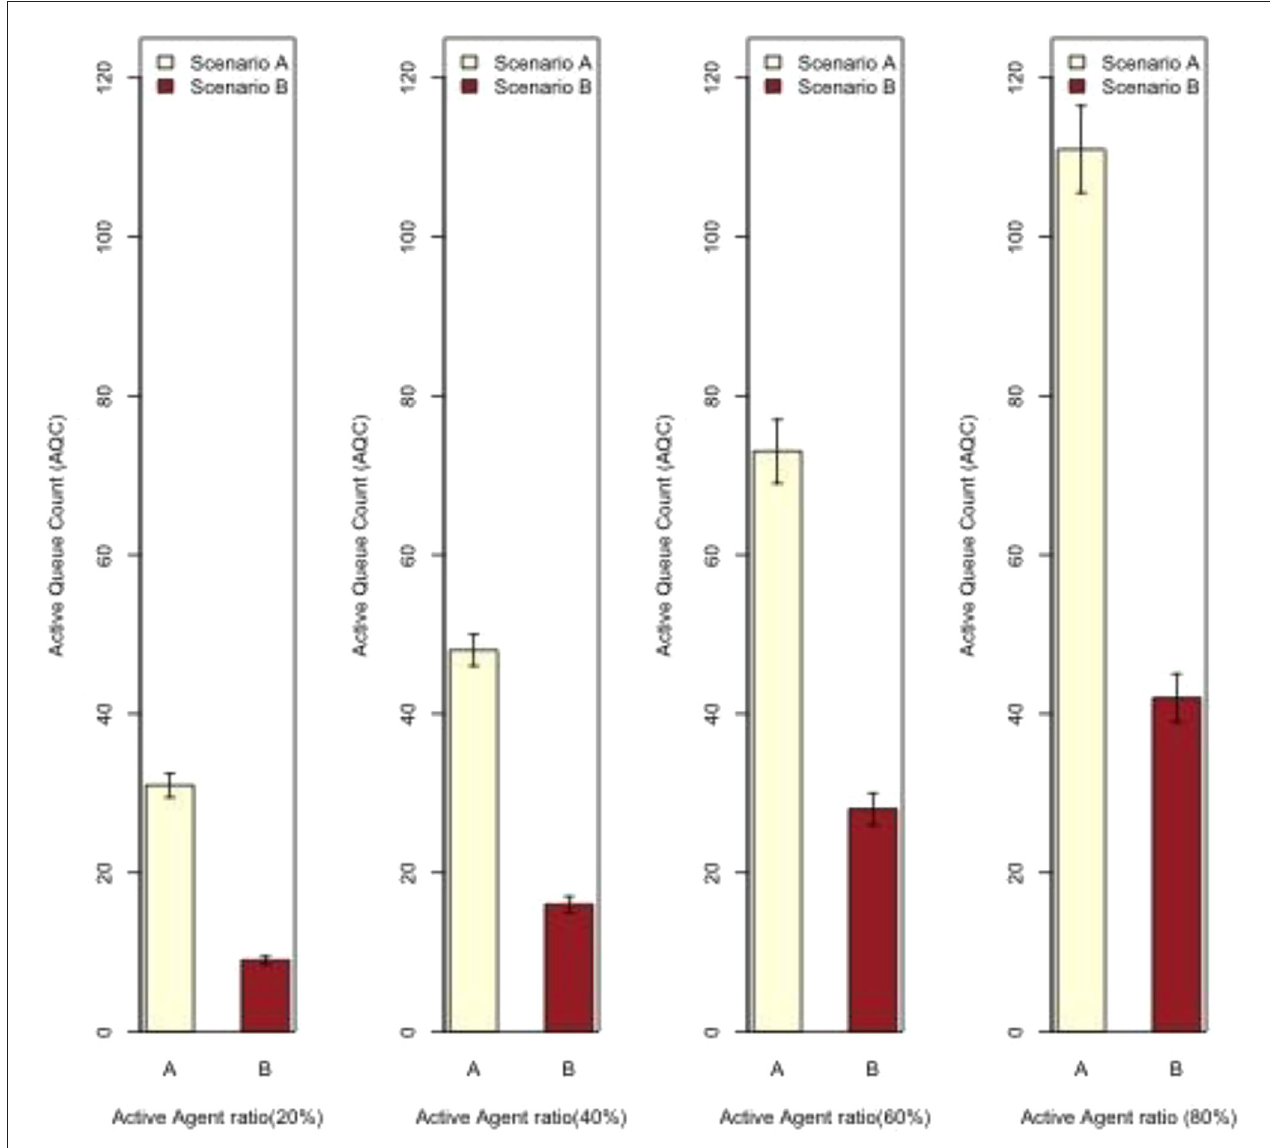
FIGURE 7 | AQC for conventional (Scenario A) and proposed (Scenario B) hours (source: the authors).